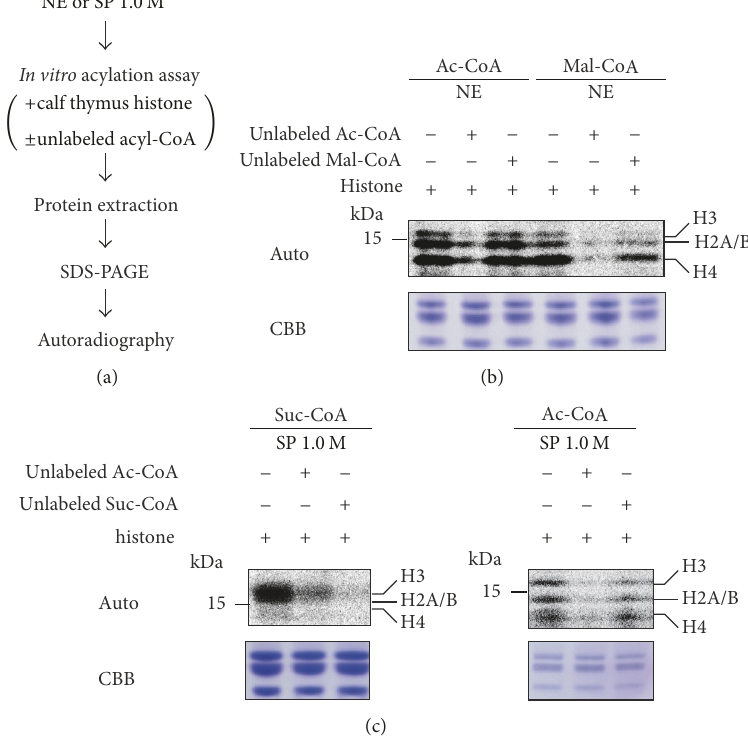
Figure 4: Competition assay for acyl-coenzyme A incorporation into histone proteins. (a) Schematic diagram of in vitro acylation assay with unlabeled acyl-CoA for substrate competition. In vitro histone acylation assays with nonlabeled acyl-coenzyme A. 14 C-labeled coenzyme A incorporation into histone proteins in the presence of an excess amount (5 nmol) of nonlabeled malonyl-coenzyme A (b) and succinyl- coenzyme A (c) was assessed by autoradiography. Acetyl-coenzyme A was used as a control for the substrate specificity. The amounts of added substrate (calf thymus histone proteins) in each reaction were visualized by Coomassie Brilliant Blue (CBB). Molecular weights are indicated on the left side of the figure, and each histone position (histones H3, H2A/B, and H4) is indicated in the right side of the figure.